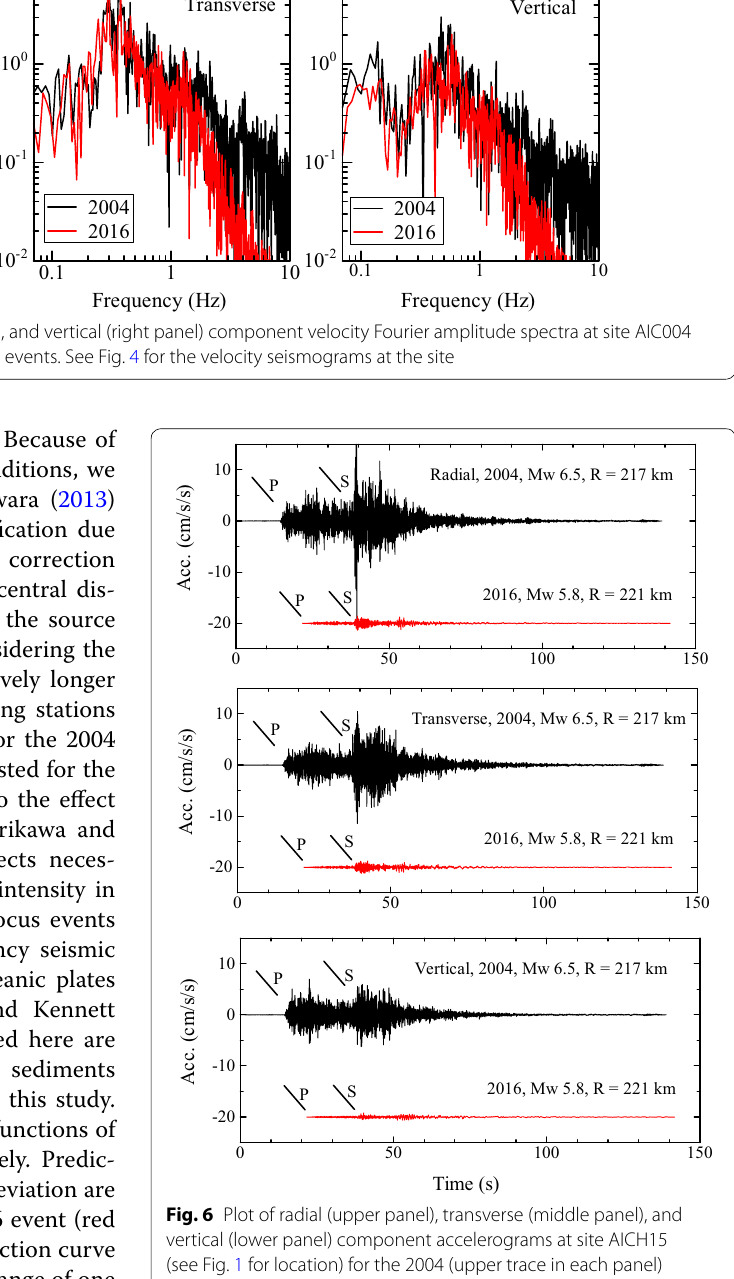
Fig. 6 Plot of radial (upper panel), transverse (middle panel), and vertical (lower panel) component accelerograms at site AICH15 (see Fig. 1 for location) for the 2004 (upper trace in each panel) and 2016 (lower trace in each panel) events. The recordings are aligned to match the S-wave arrivals. The arrivals of P- and S-waves are indicated by the letters P and S, respectively. The hypocentral distance (R) is rounded to the nearest whole number. See Fig. 7 for the bandpass-filtered velocity seismograms at the site and Fig. 9 for a comparison of the adjusted PGAs and PGVs among the sites